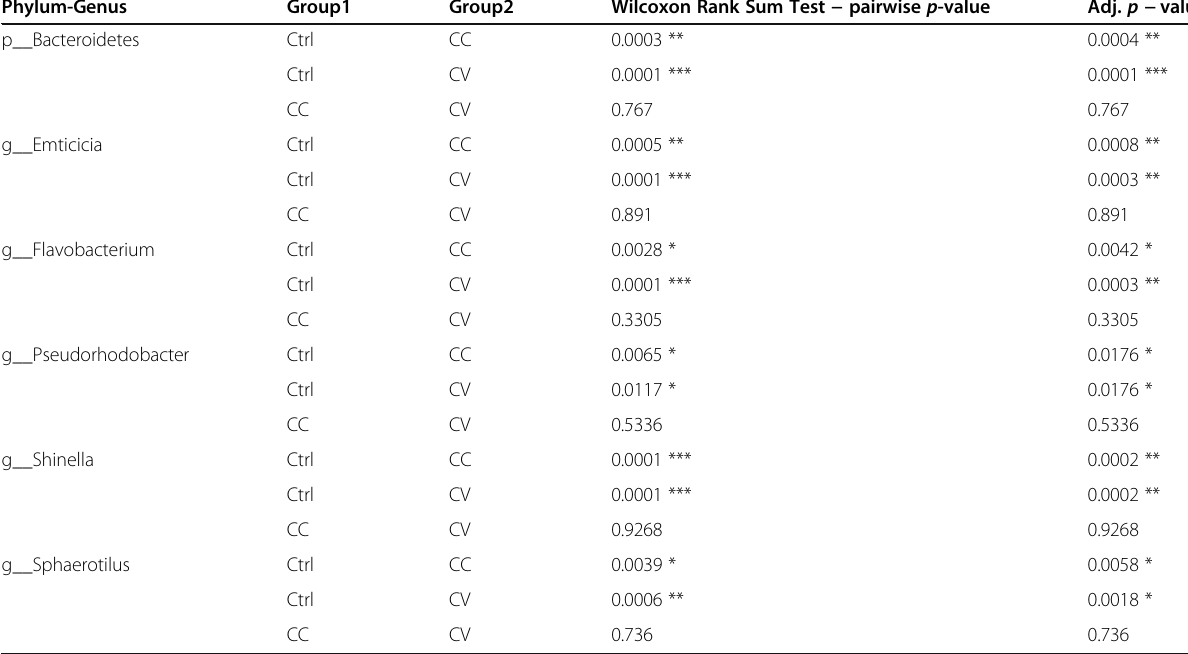
Table 1 Statistical summary of taxonomic significant changes between treatments